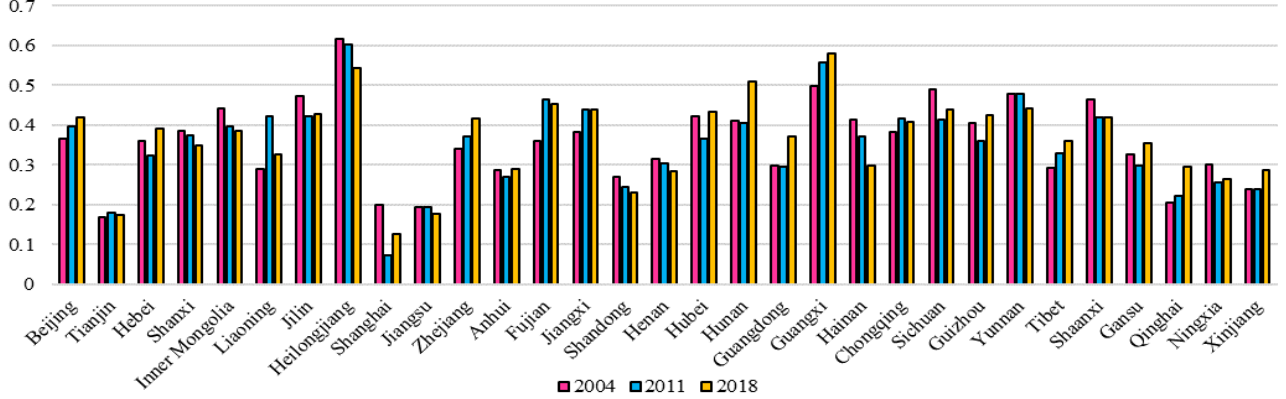
Figure 1. Comprehensive index of forest ecological security.